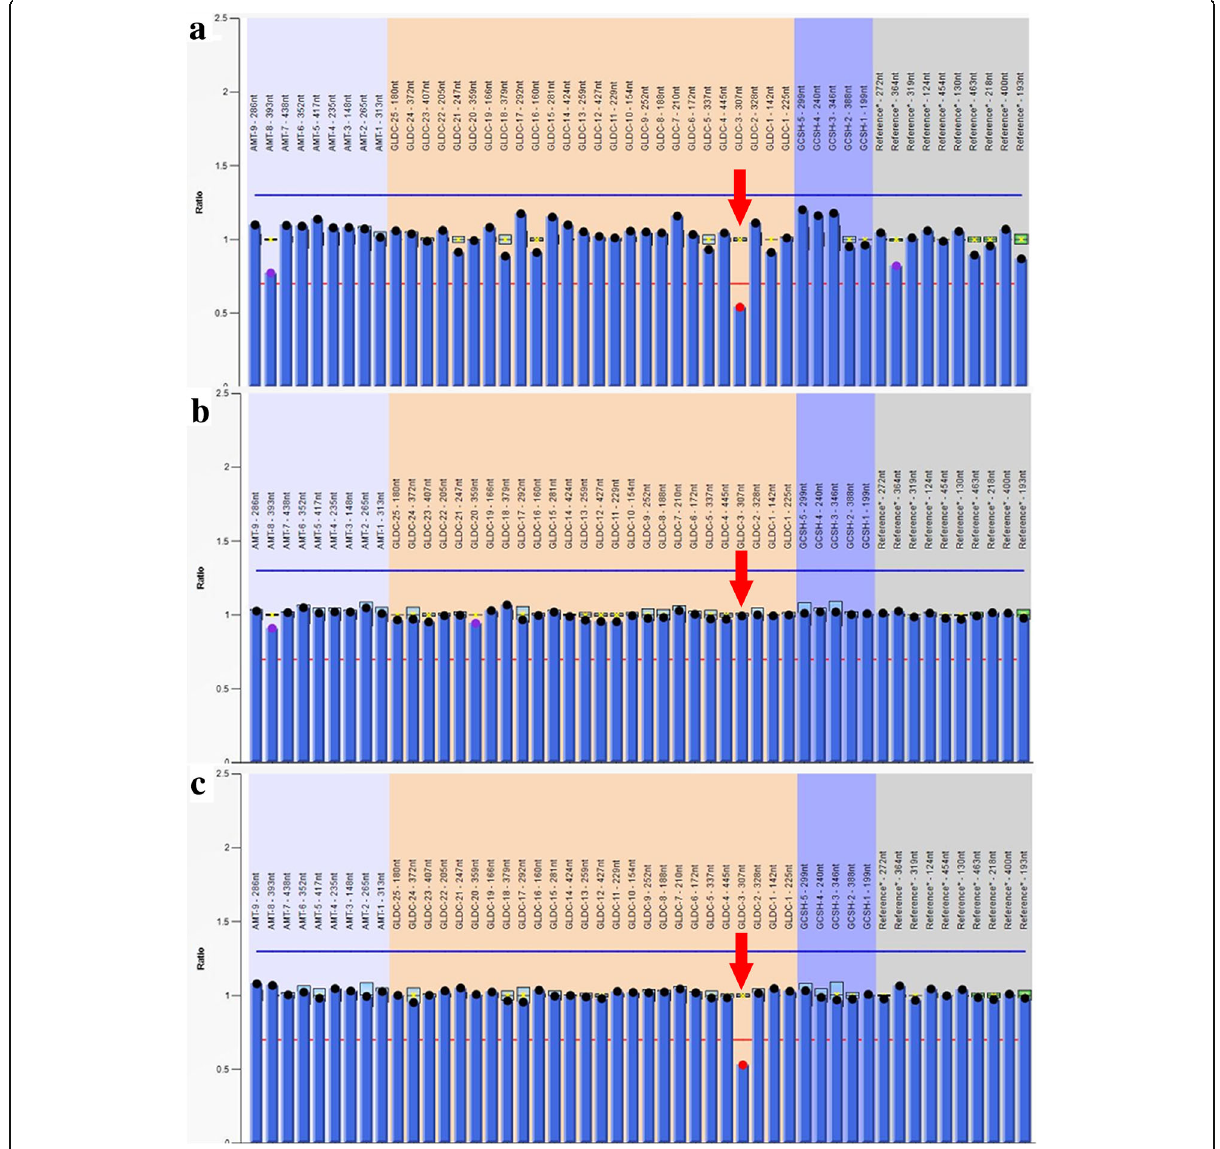
Fig. 2 Multiplex ligation-dependent probe amplification analysis of GLDC , AMT and GCSH genes. A heterozygous deletion of exon 3 in GLDC gene was detected in the proband ( a ) and his father ( c ), but not in his mother ( b